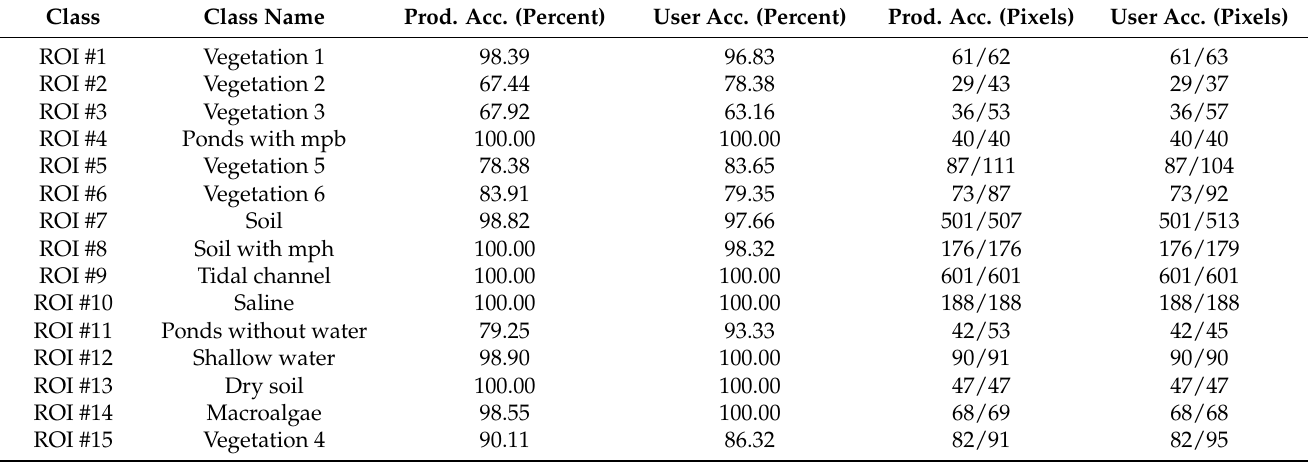
Table A4. Report for the accuracy of the comparison of classification results to R10, the random samples group using 10% of total pixels as reference. The table summarizes the producer accuracy and user accuracy in percentage and pixels for each